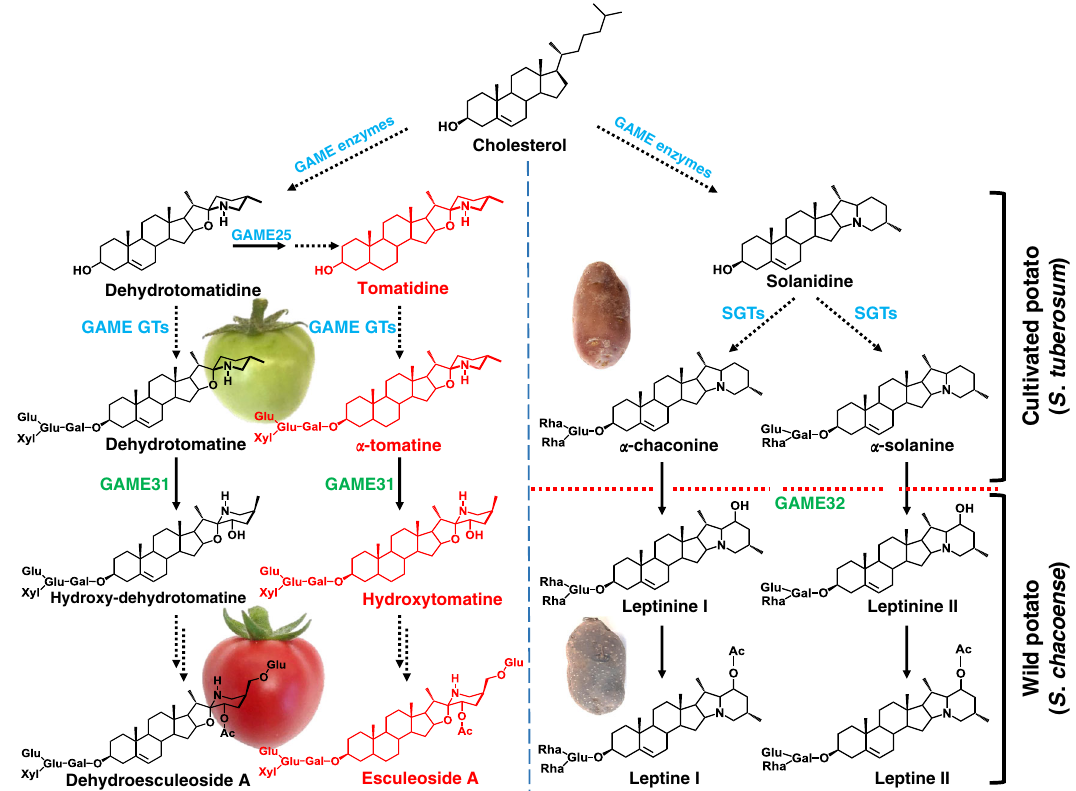
Fig. 1 A simpli fi ed scheme of core steroidal glycoalkaloid modi fi cation in tomato and potato species. In tomato, during transition from green to red fruit, the core α -tomatine is bitter steroidal glycoalkaloid (SGA) and converted to the non-bitter esculeoside A and additional SGAs. The main SGAs in cultivated potato are α -chaconine and α -solanine. Both cultivated potato and S. chacoense share a common pathway up to the biosynthesis of α -chaconine and α -solanine. These SGAs are hydroxylated to form leptinines (leptinine I and leptinine II) and subsequently leptines (leptine I and leptine II) that are unique to the wild potato, S. chacoense . The known SGAs biosynthetic genes are shown in blue color. GAME31 and GAME32 genes characterized in this study are marked in green. Dashed and solid arrows suggest multiple or single enzymatic steps in the pathway, respectively. A detailed tomato SGAs biosynthetic pathway is presented in Supplementary Fig. 1. GAME GLYCOALKALOID METABOLISM, SGT STEROL ALKALOID GLYCOSYLTRANSFERASE, Ac Acetoxy, Glu Glucose, Gal Galactose, Xyl Xylose, Rha Rhamnose. α -tomatine-derived SGAs are marked in red while dehydrotomatine-derived SGAs are shown in